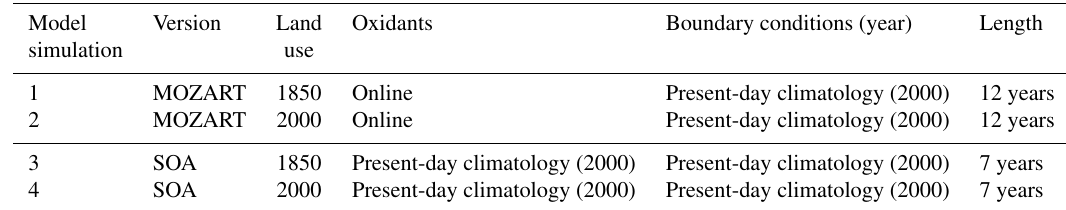
Table 1. Simulations of aerosol–climate effects of anthropogenic land use. MOZART refers to a version of NorESM1-CRAICC coupled with a tropospheric chemistry